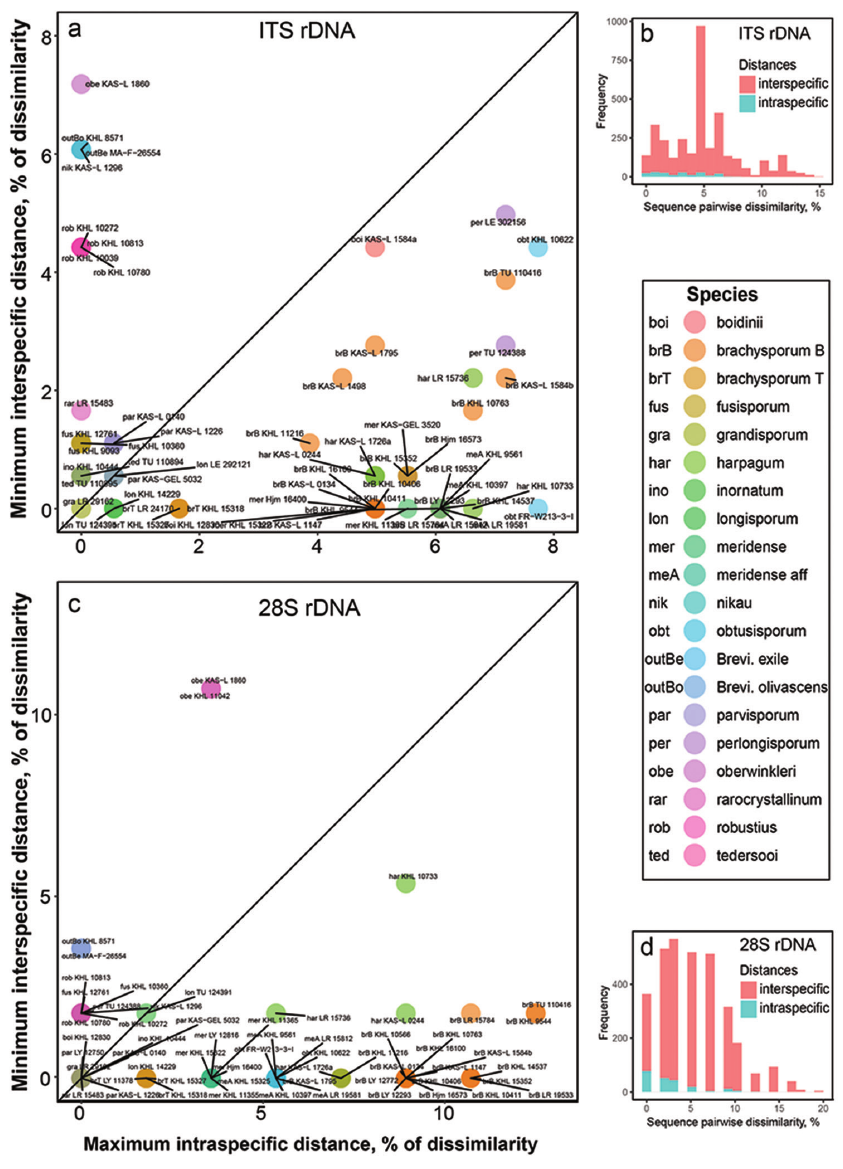
Figure 2. Verifying the presence of the barcode gap in Subulicystidium rDNA sequences of ITS ( a, b ) and 28S ( c, d ) regions. a, c Maximal intraspecific divergence compared with minimal interspecific distances between the aligned rDNA sequences in ITS ( a ) and 28S ( c ) datasets. Specimens falling above 1:1 line in- dicate the presence of the barcoding gap (molecular distinctness of the species) b, d Frequency distributions of intra- and interspecific distances without referring to particular species in ITS ( b ) and 28S ( d ) datasets. In the legend, the capital “B” following epithet in S. brachysporum means morphological species concept following Boidin and Gilles (1988), while “T” means the species as described by Talbot (1958). Three-letter code before each specimen’s number corresponds to a species epithet as explained in the